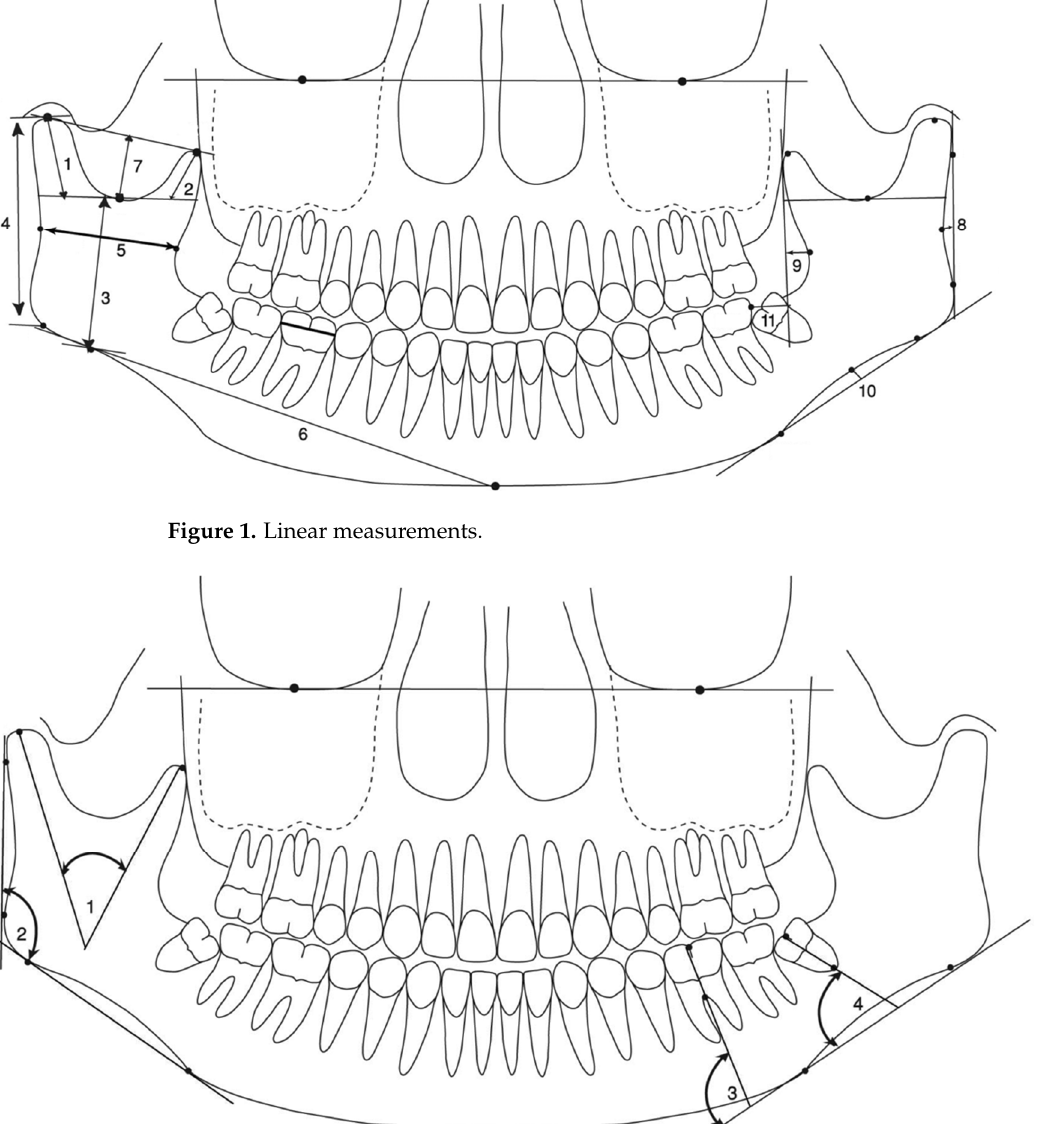
Figure 2. Angular measurements. Figure 2. Angular